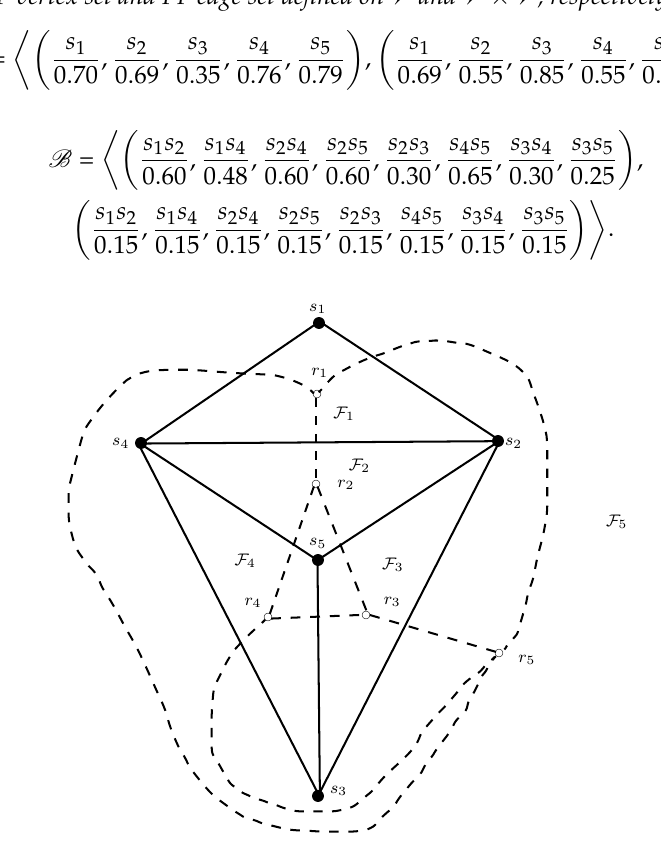
Figure 5.2: Pythagorean fuzzy dual graph Figure 11. Pythagorean fuzzy dual